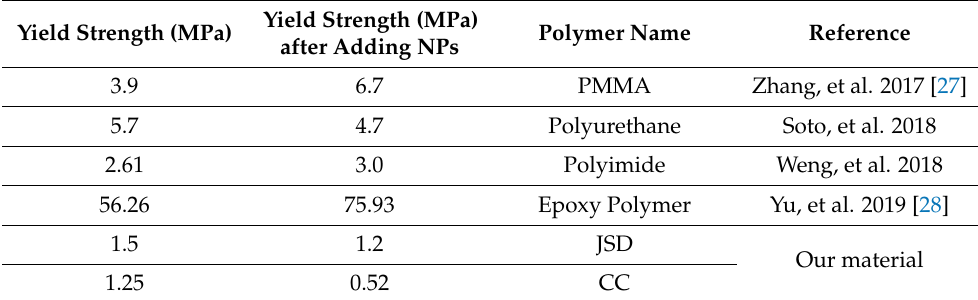
Table 7. Comparing this work to previous